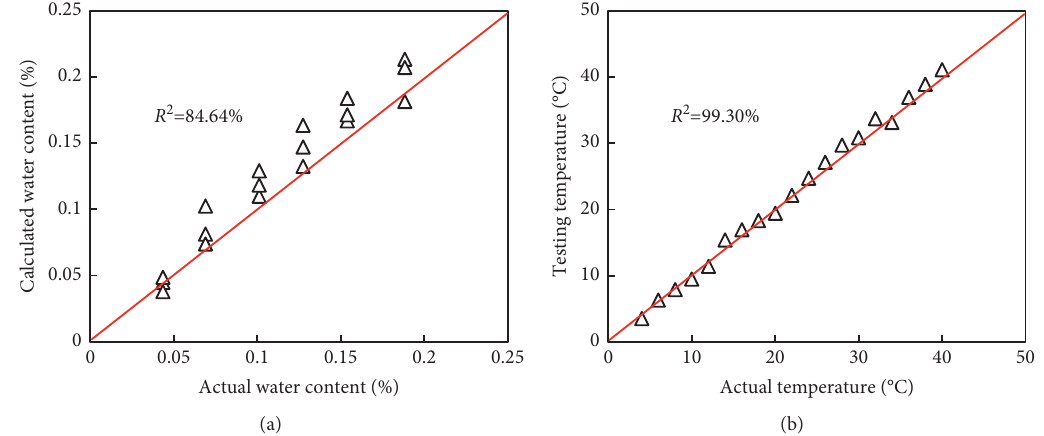
Figure 4: Testing results of (a) moisture content and (b) temperature in the